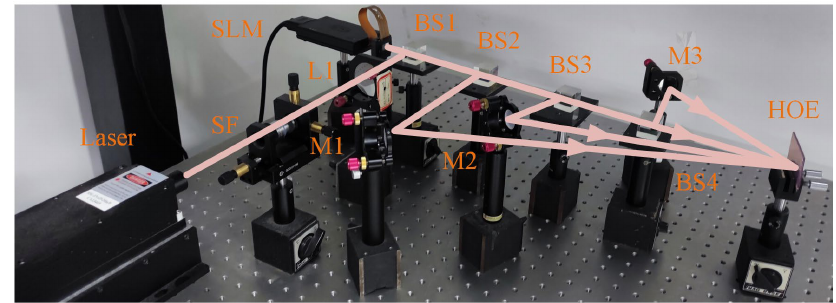
Figure 6. The prototype of the proposed multiview holographic 3D